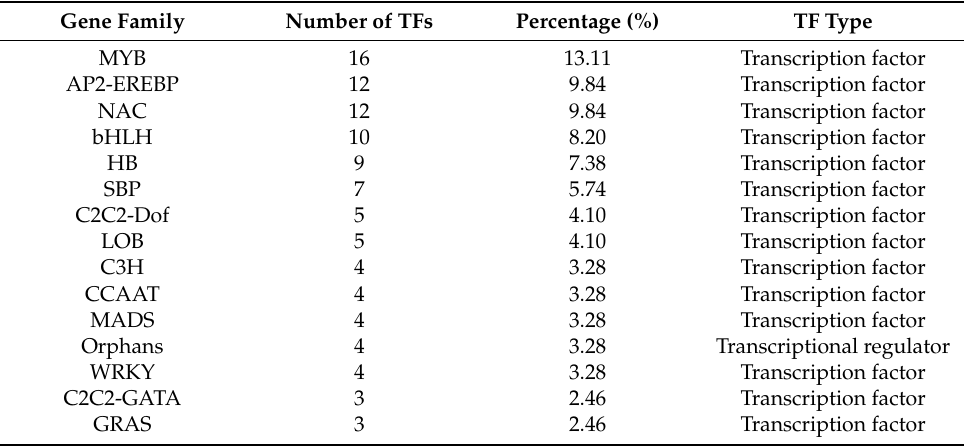
Table 3. Transcription factor (TF) analysis results of DEGs between normal temperature (NT) and moderately high temperature (MHT) exposed tobacco leaves Gene